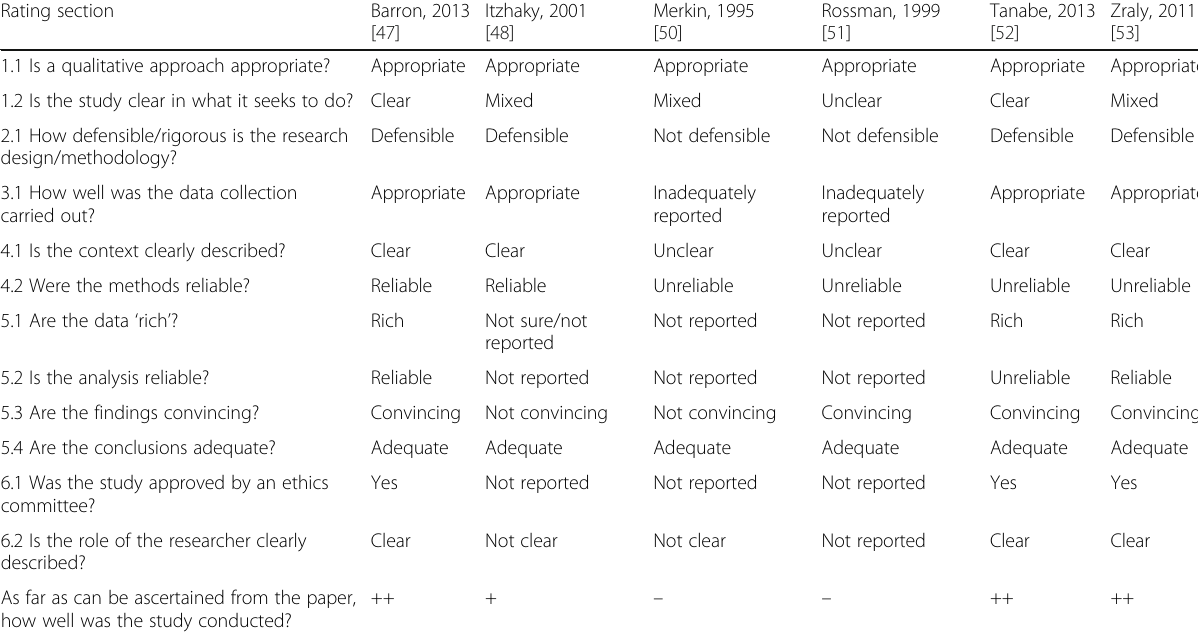
Table 4 Methodological quality assessment for qualitative studies Rating